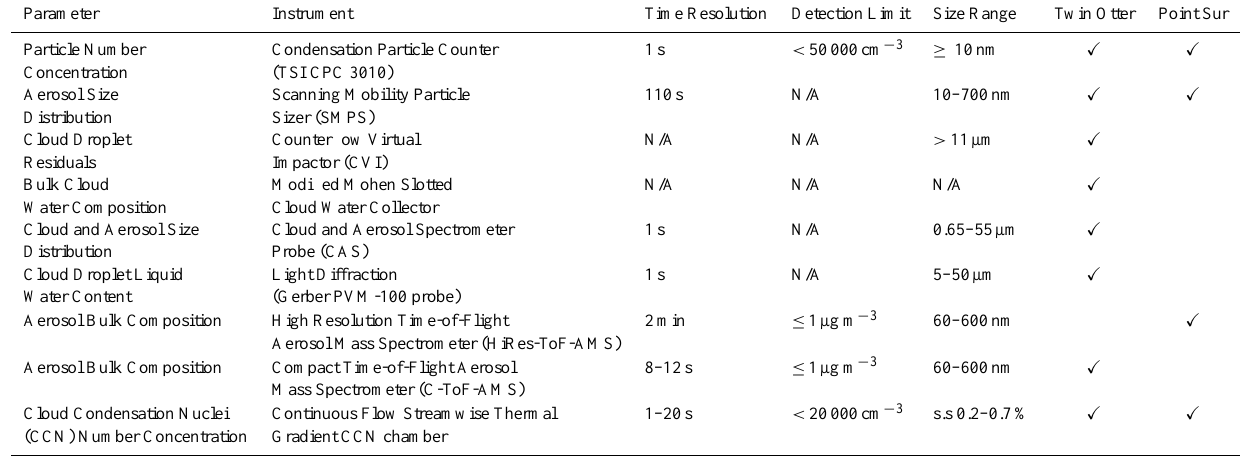
Table 2. Instruments onboard the Twin Otter aircraft and R/V Point Sur .